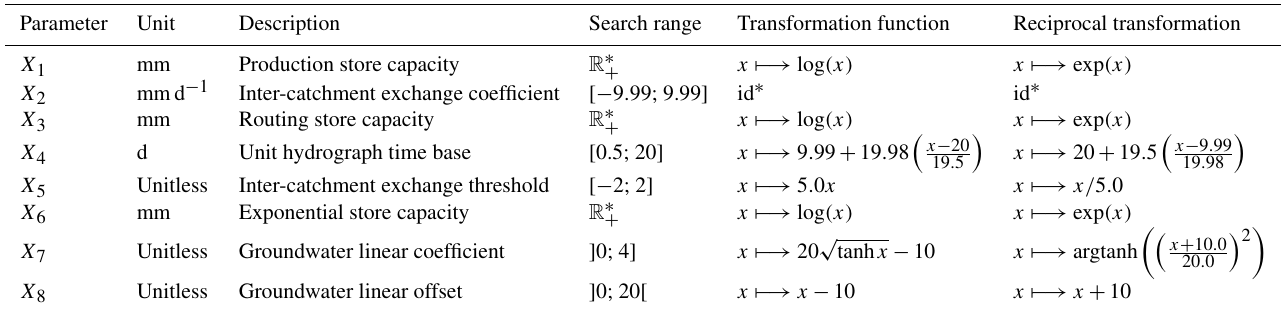
∗ id stands for identity